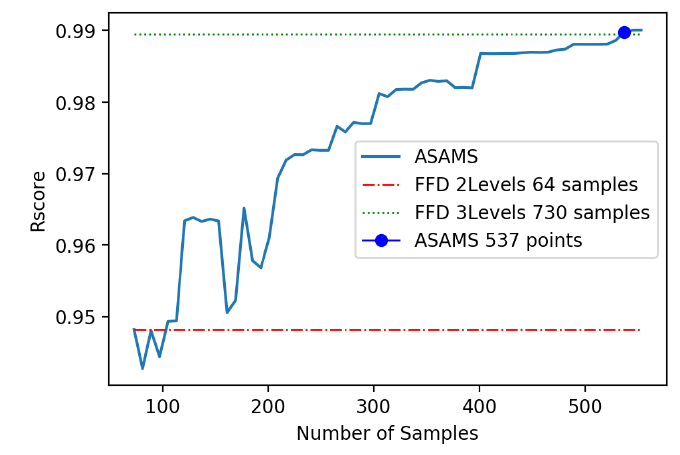
Figure 9. Baseline comparison of nonlinear oscillator.